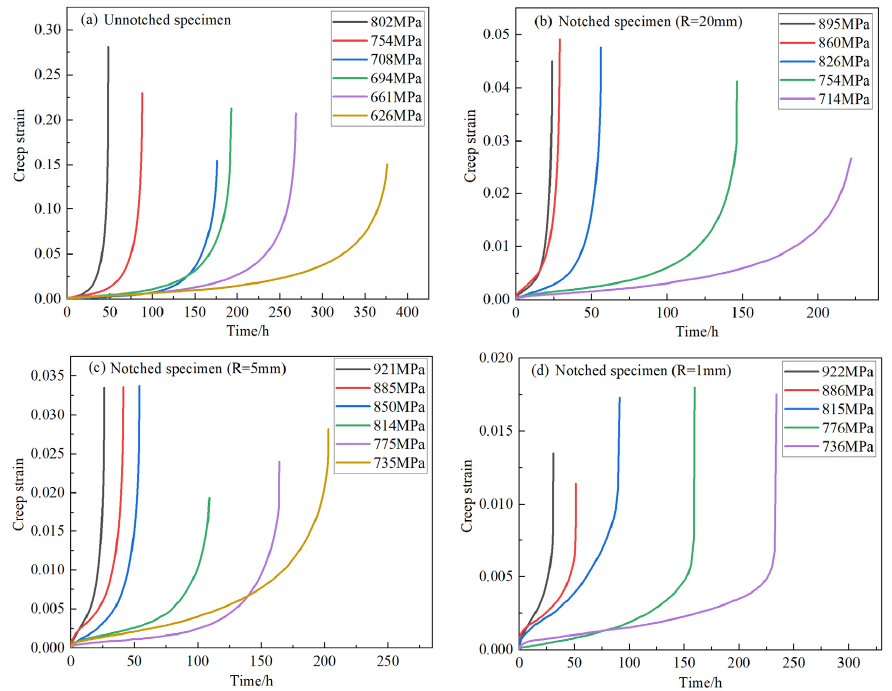
Figure 5. Creep curve: ( a ) Unnotched specimen; ( b ) Notched specimen (R = 20 mm); ( c ) Notched specimen (R = 5 mm); ( d ) Notched specimen (R = 1 mm).